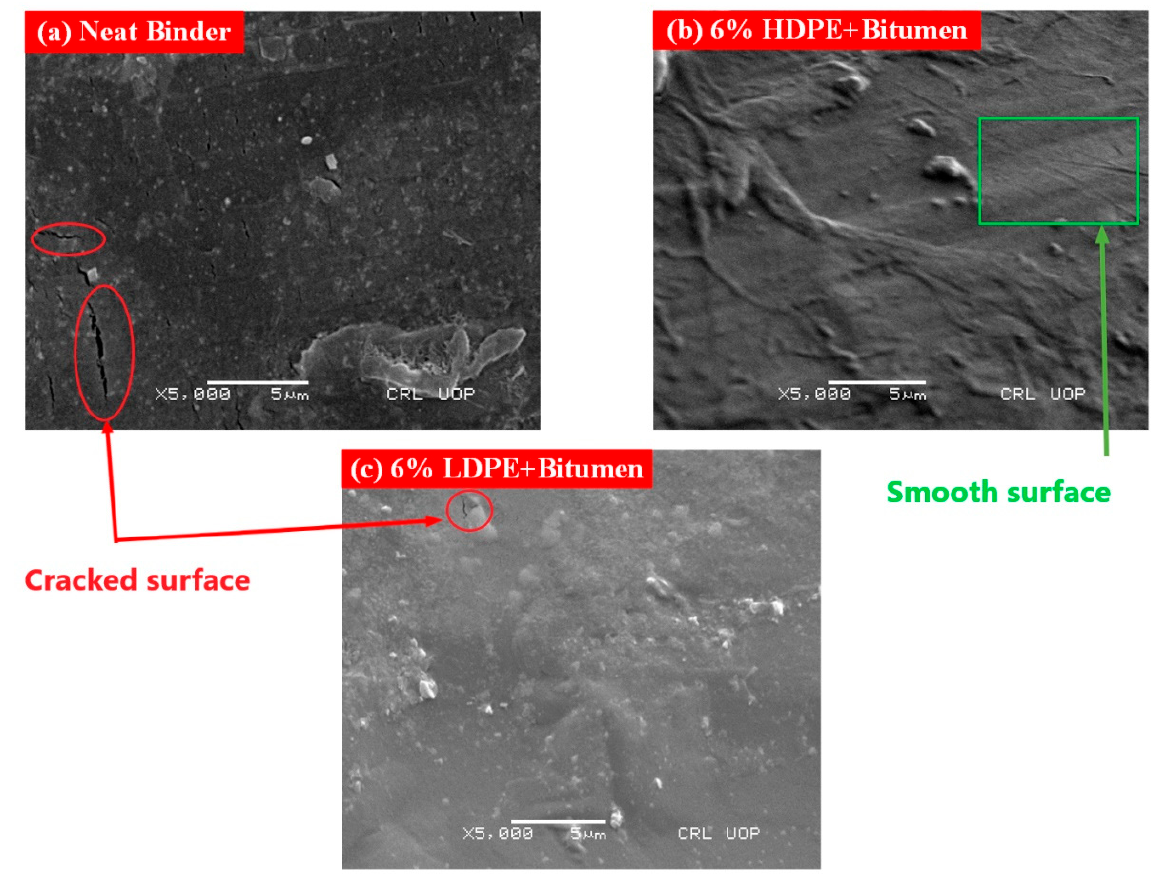
Figure 4. SEM images: ( a ) Neat Binder; ( b ) HDPE modified bitumen; ( c ) LDPE modified bitumen.